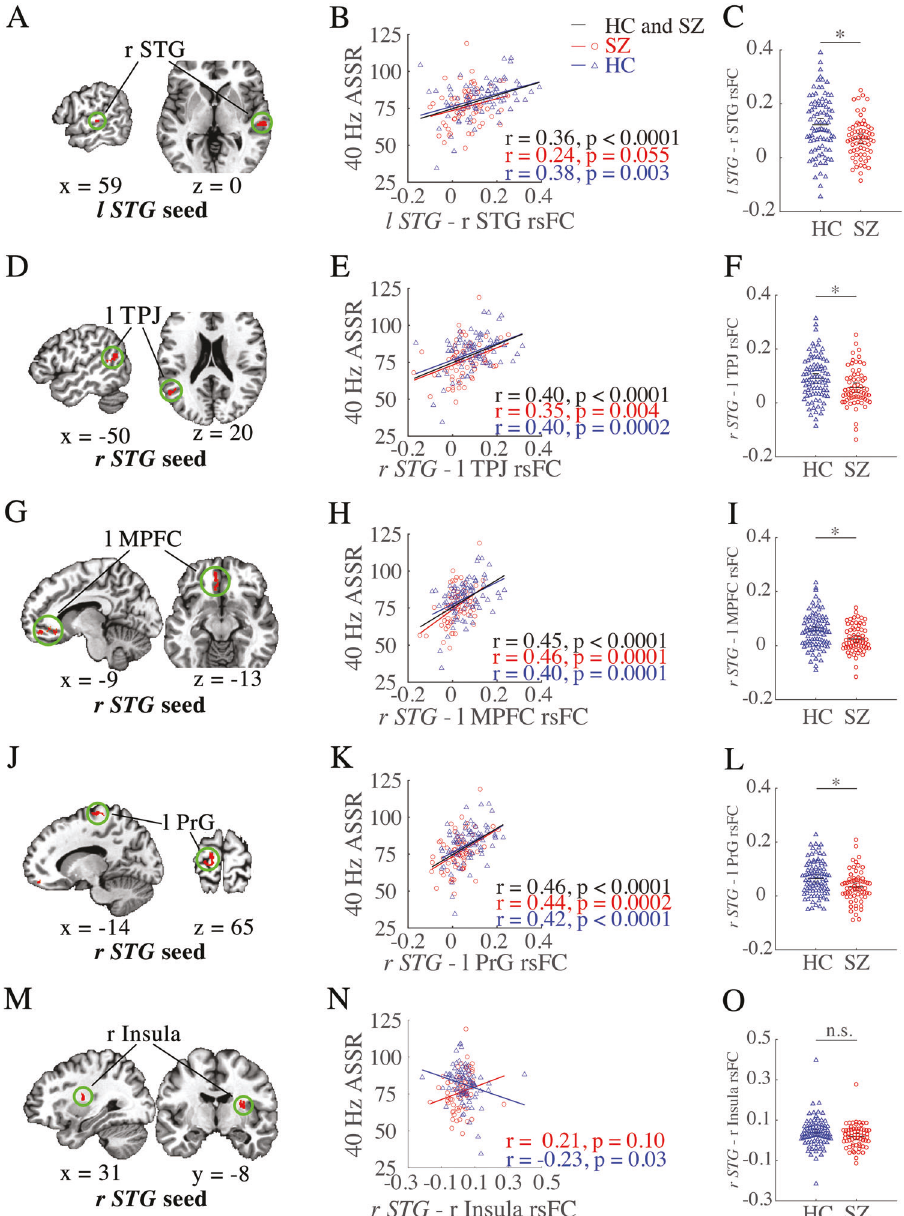
Fig. 2 Five brain regions whose resting-state functional connectivity (rsFC) with superior temporal gyrus (STG) were associated with 40 Hz auditory steady-state response (ASSR). The fi ve brain regions are shown in fi ve sets of fi gures ( A , D , G , J , M ) on the left column and each region is shown by sagittal and axial views. A is from the left STG seed. The remaining D – M are from the right STG seed. A Left STG - seeded rsFC with right STG was signi fi cantly and positively linked to 40 Hz ASSR in the combined groups and within each group ( B ); and was signi fi cantly weaker in schizophrenia patients as compared with healthy individuals ( C ). D – O : Right STG -seeded rsFC with left temporoparietal junction (TPJ) ( D ), left medial prefrontal cortex (MPFC) ( G ), and left precentral gyrus (PrG) ( J ) also signi fi cantly predicted 40 Hz ASSR in both combined groups and within each group ( E , H , K ), and patients with schizophrenia showed signi fi cantly weaker rsFC ( F , I , L ). The only rsFC × ASSR interaction was found at right STG — right insula rsFC ( M , N ), but this rsFC was not signi fi cantly different between the two diagnostic groups ( O ). Seed region was written in italic. * FDR corrected p < 0.05 for fi ve comparisons. n.s. non-signi fi cant. The left is shown on the left side of the MRI showed that none of them was signi fi cantly different between the temporoparietal junction (TPJ) (Fig. 2A, D; all statistical details also diagnostic groups ( z = 0.14 to 0.91, p = 0.37 – 0.89). Meanwhile, in Table 2); (3) between right STG — left medial prefrontal cortex schizophrenia patients had signi fi cantly weaker rsFC as compared (MPFC); and (4) between right STG — left precentral gyrus (PrG) with healthy individuals at all these rsFC (Fig. 2C, F, I, L). These (Fig. 2G, J). These positive associations between rsFC and 40 Hz fi ndings suggest that these rsFC signi fi cantly contributed to 40 Hz ASSR across groups were also signi fi cant in patients and controls ASSR independently in schizophrenia patients and healthy independently in most rsFC (except left STG — right STG rsFC, which controls, while the same rsFC were also signi fi cantly reduced in was only present in the schizophrenia group) (Fig. 2B, E, H, K). The schizophrenia patients. comparisons of the correlation coef fi cients among these rsFC